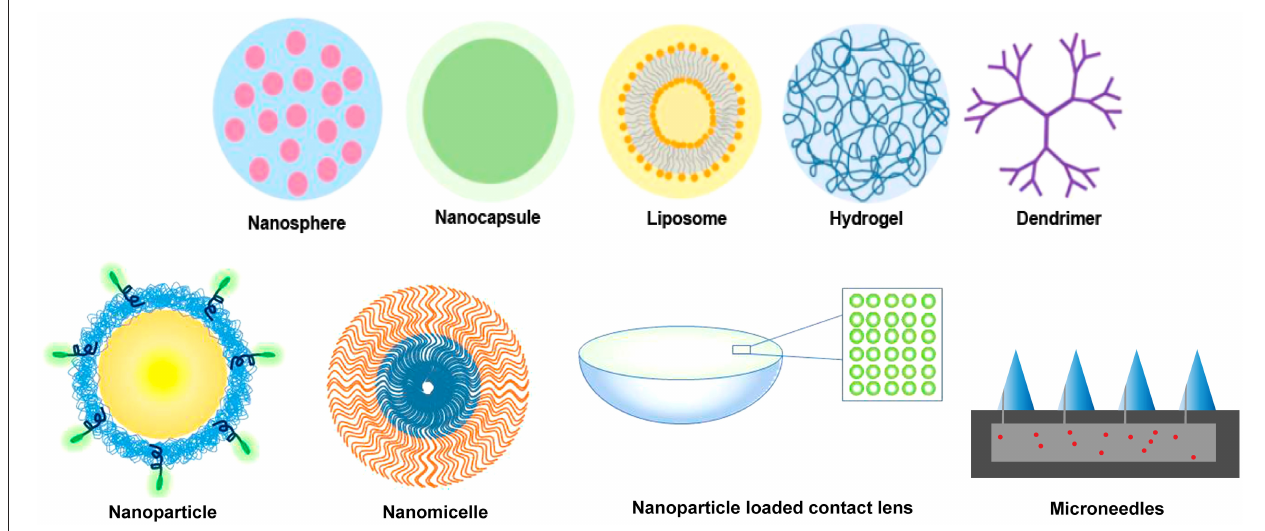
FIGURE 4 | Various polymer forms that have been applied to facilitate and modulate ocular drug delivery at the macroscale and nanoscale. Both synthetic and biopolymers can be formulated into nanospheres, nanocapsules, liposomes, hydrogels, dendrimers, nanoparticles, nanomicelles, and microneedles. Nanoscale polymers can be incorporated into composites, such as the hydrogel-based contact lens shown with nanoparticles.